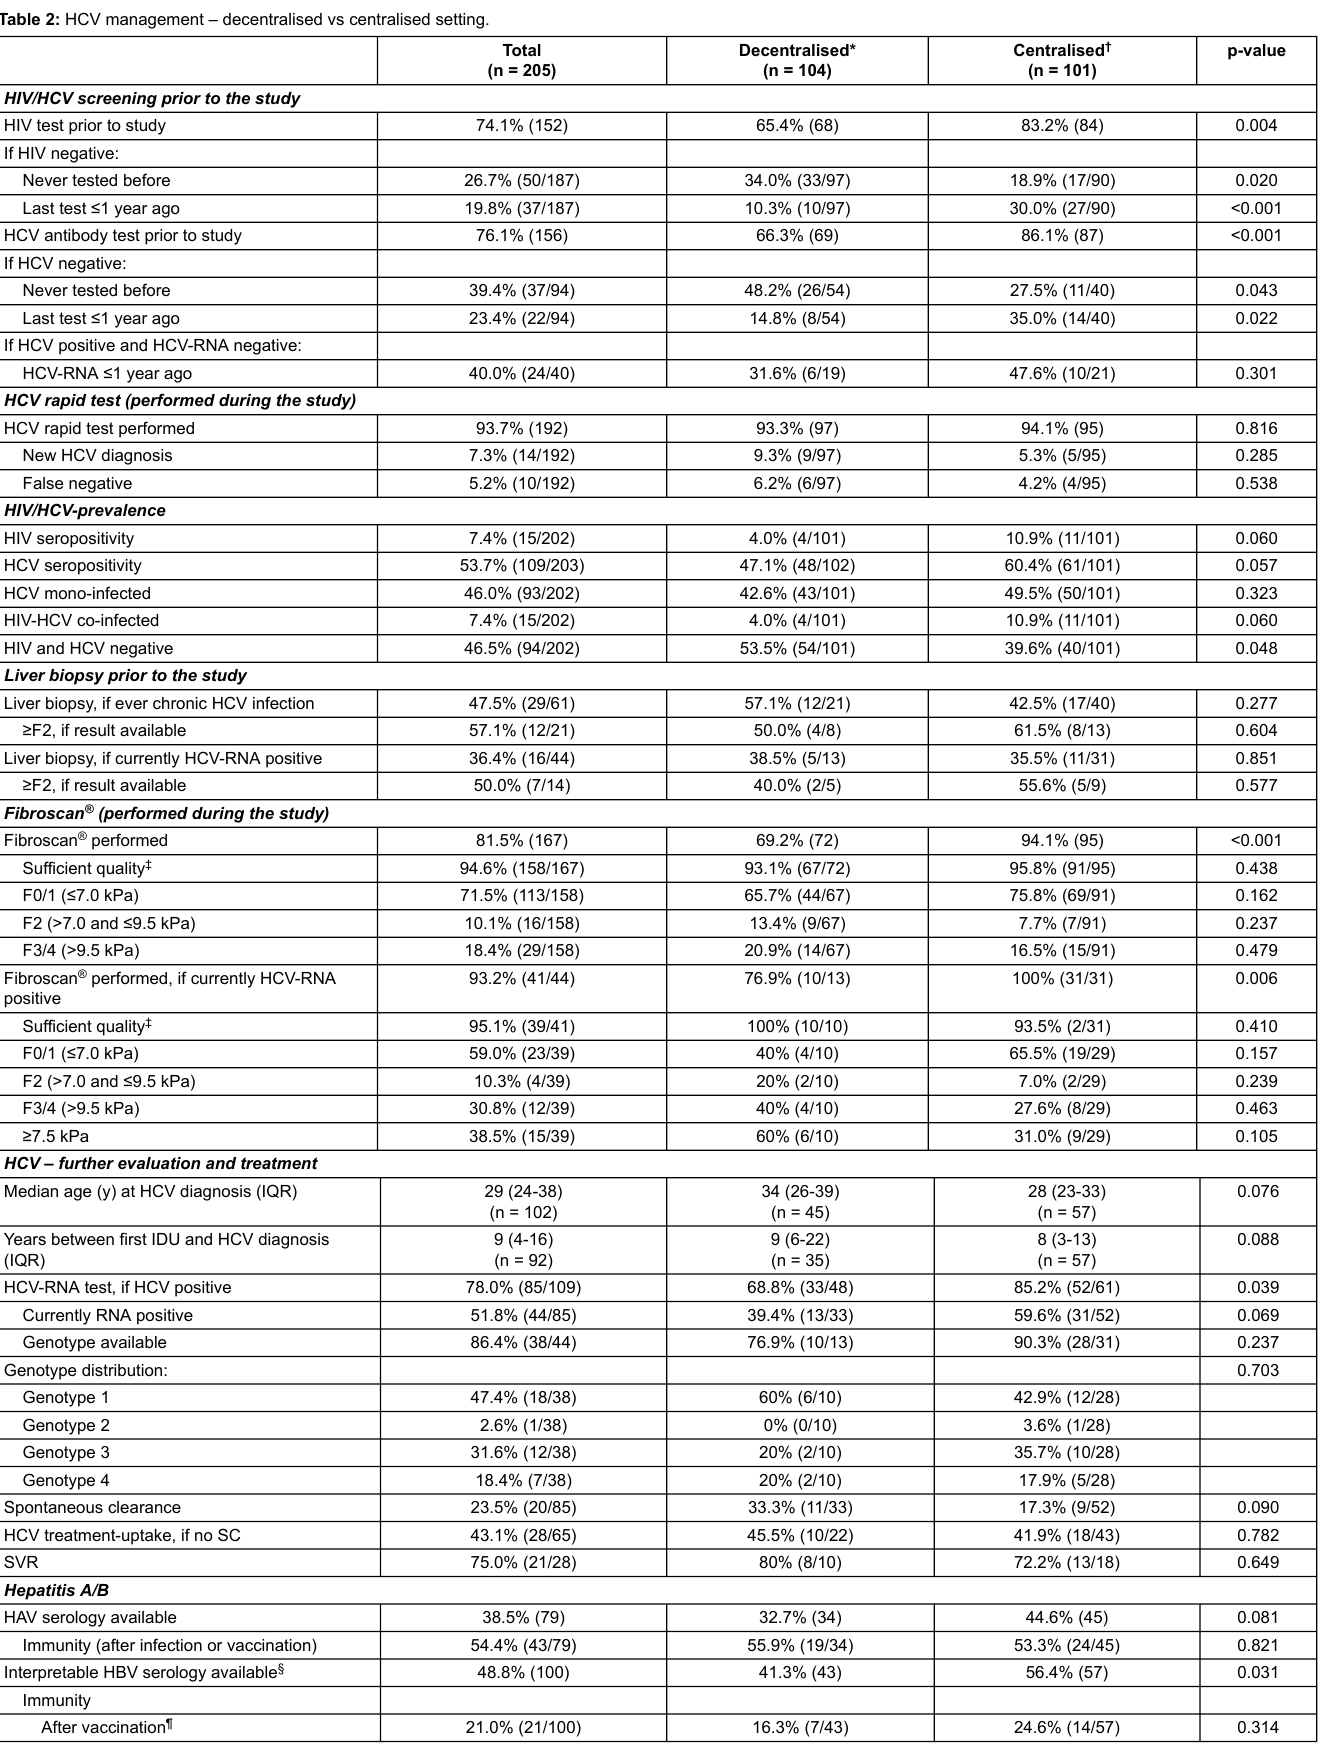
Table 2: HCV management – decentralised vs centralised